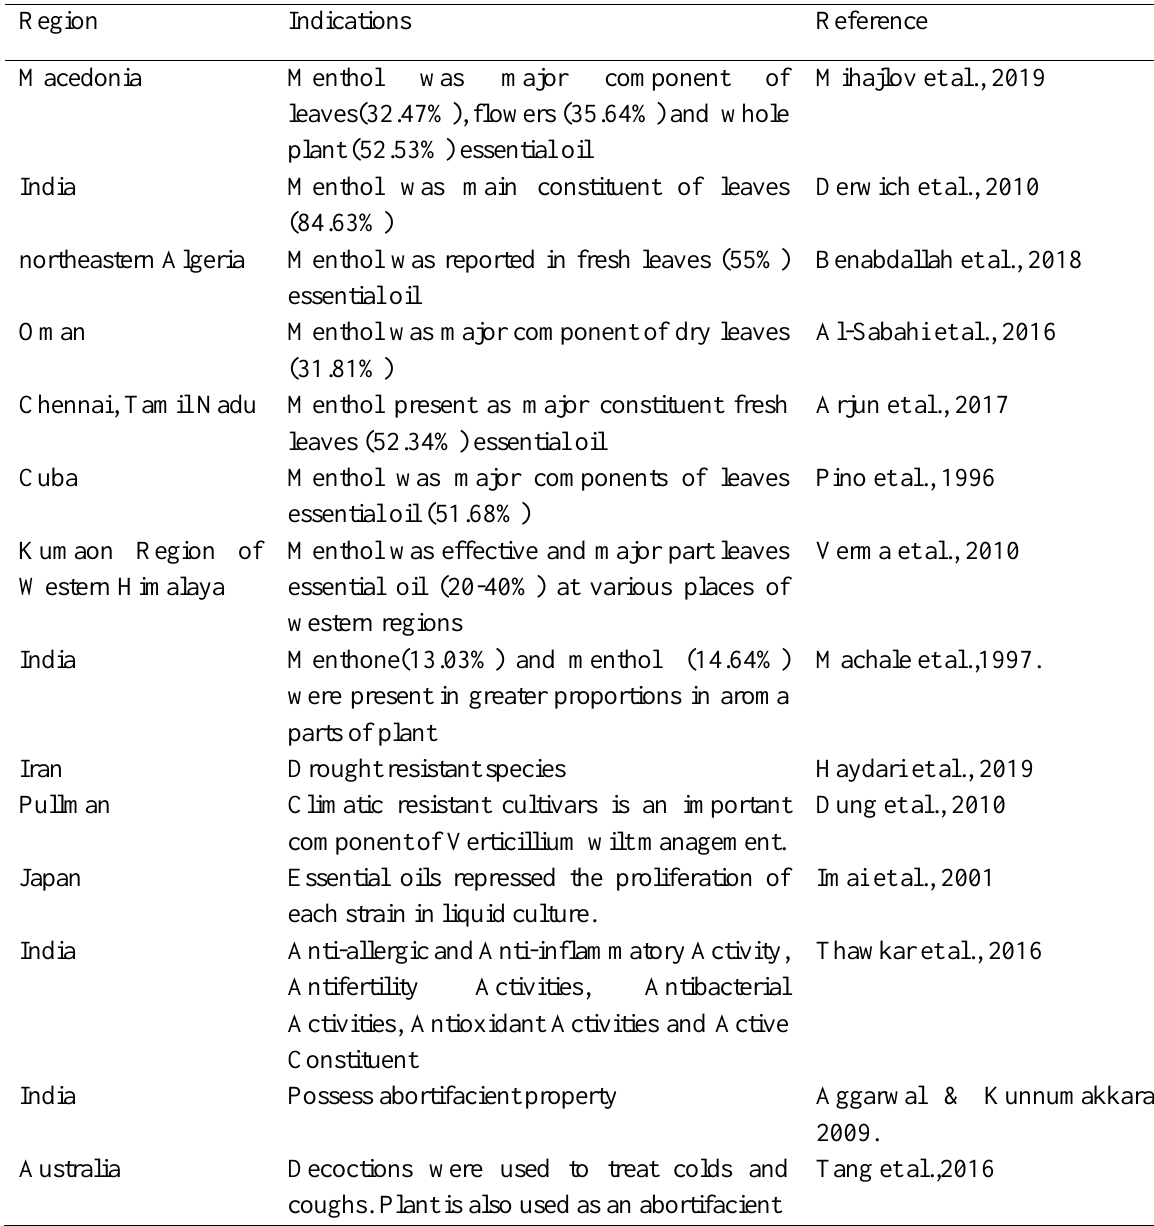
Table 2 Broader uses and properties of Mentha arvensis in different regions of